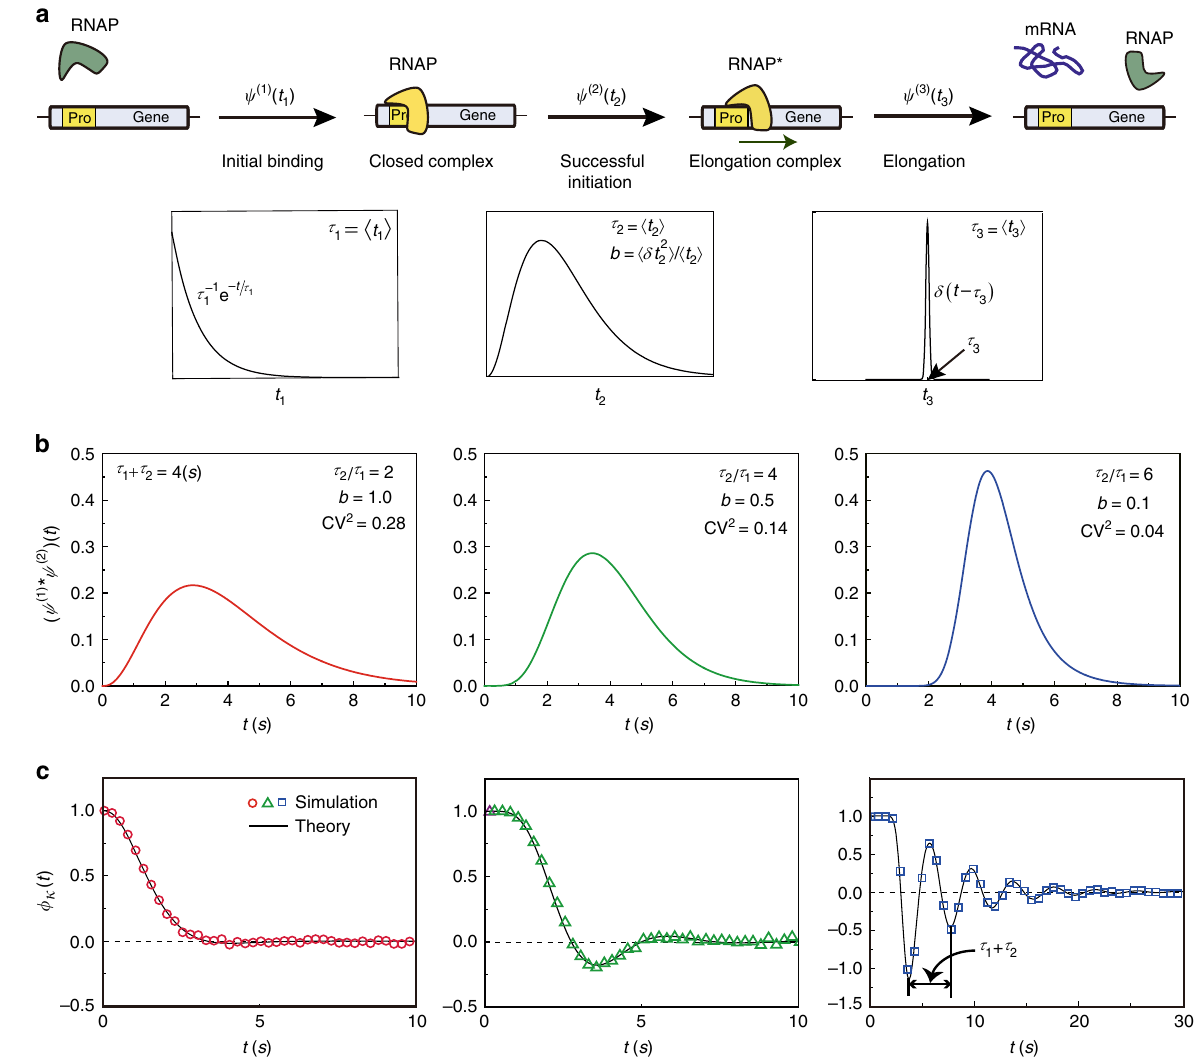
Fig. 3 Non-Poisson transcription dynamics and TCF of the transcription rate of an unrepressed gene. a A simple model of the non-Poisson transcription process: (Step 1: Initial binding) initial binding of RNAP to promoter to form the closed complex; (Step 2: Successful initiation) transition of the RNAP- promoter complex into the elongation complex; and (Step 3: Elongation) synthesis of mRNA. Step 1 is modeled as a Poisson process with the mean reaction (cid:2) t 1 = τ 1 . The reaction waiting time of Step 2 is modeled as a gamma time, τ 1 , for which the reaction waiting time is distributed according to ψ ð 1 Þ ð t 1 Þ ¼ τ (cid:2) 1 (cid:4) (cid:5) 1 e = t (cid:2) t 2 = b = Γ a ð Þ b a ð Þ , with t 2 h i ¼ ab (cid:4) τ 2 ð Þ and δ t 2 distribution, ψ 2 ð Þ t 2 ð Þ ¼ t a (cid:2) 1 2 h i (cid:4) b . The elongation process (Step 3) is a highly sub-Poisson process for 2 e 2 which the reaction time is modeled as ψ ð 3 Þ ð t 3 Þ ¼ δ ð t 3 (cid:2) τ 3 Þ . The next round of RNAP binding to the promoter is not allowed before the preceding RNAP completes the second step to leave the promoter. During transcriptional elongation by RNAPs, other RNAP can associate with the promoter and proceed to the next step. Multiple RNAPs can simultaneously perform the elongation process. b Distribution of transcription waiting times or the times between successive transcription events of the single-active gene copy. This distribution is given by the convolution of ψ ð 1 Þ ð t Þ and ψ ð 2 Þ ð t Þ . The shape of the transcription waiting time distribution is shown for three different sets of parameter values for τ 1 , τ 2 , and b . The mean value, τ 1 þ τ 2 , is fi xed at 4 s. c TCF, ϕ fi cient κ ð t Þ , of the active gene transcription rate corresponding to each transcription waiting time distribution (see Supplementary Note 18). When the coef of variation (CV) in the transcription waiting time is small enough, ϕ κ ð t Þ exhibits an oscillatory feature. For the model shown in a every cell has the same transcription dynamics, in which case the oscillation period in ϕ κ ð t Þ is constant in time and approaches the mean transcription waiting time, τ 1 þ τ 2 , as the CV of the transcription waiting time decreases. In the presence of coupling to a disordered environment, the period of the oscillation in ϕ κ ð t Þ gradually increases over time, as shown by the blue line in Fig. 2b (Supplementary Note 6 and Supplementary Figure 7). Further details on the stochastic simulation method used in Fig. 3b, c can be found in Supplementary Note